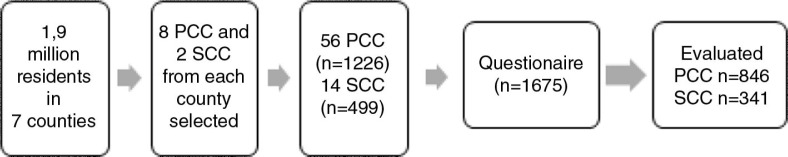
Flow chart for study conductance. Patients were selected from seven counties in central Sweden with approximately 1.9 million residents. (PCC=primary care center, SCC=secondary care center).